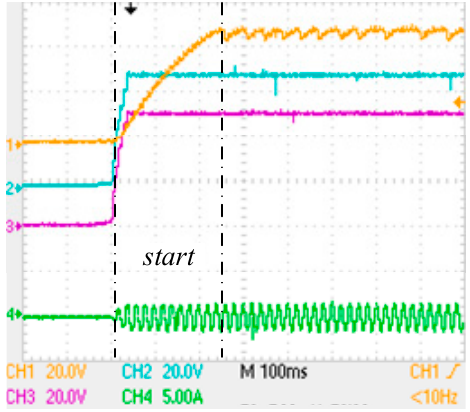
Figure 19. Start the experiment when SPM applied. (CH1: DC-link voltage of Module 1; CH2: DC-link